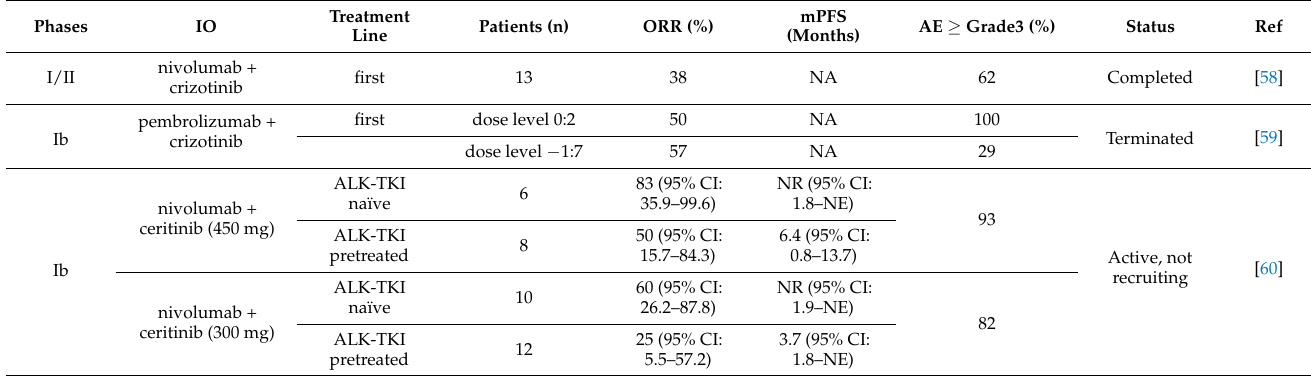
Table 6. Results of clinical trials of IO + TKI combination therapy.